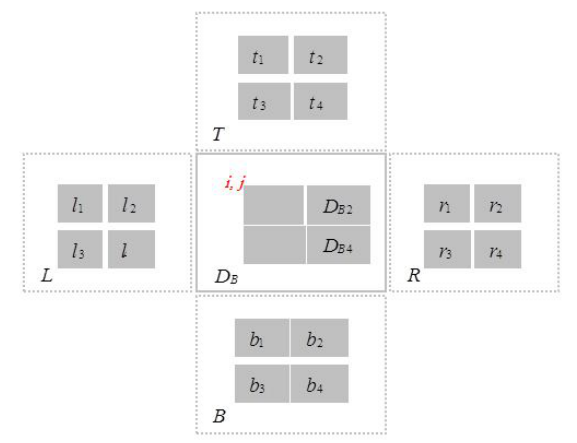
Fig. 2. The proposed interpolation scheme for 2 × 2 damaged blocks.